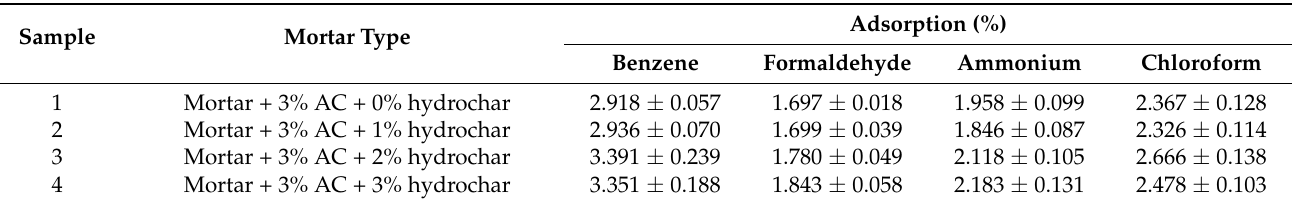
Table 12. The pollutant adsorption capacity of mortar with 3% OPS-activated charcoal and OPEFB hydrochar fibre at various